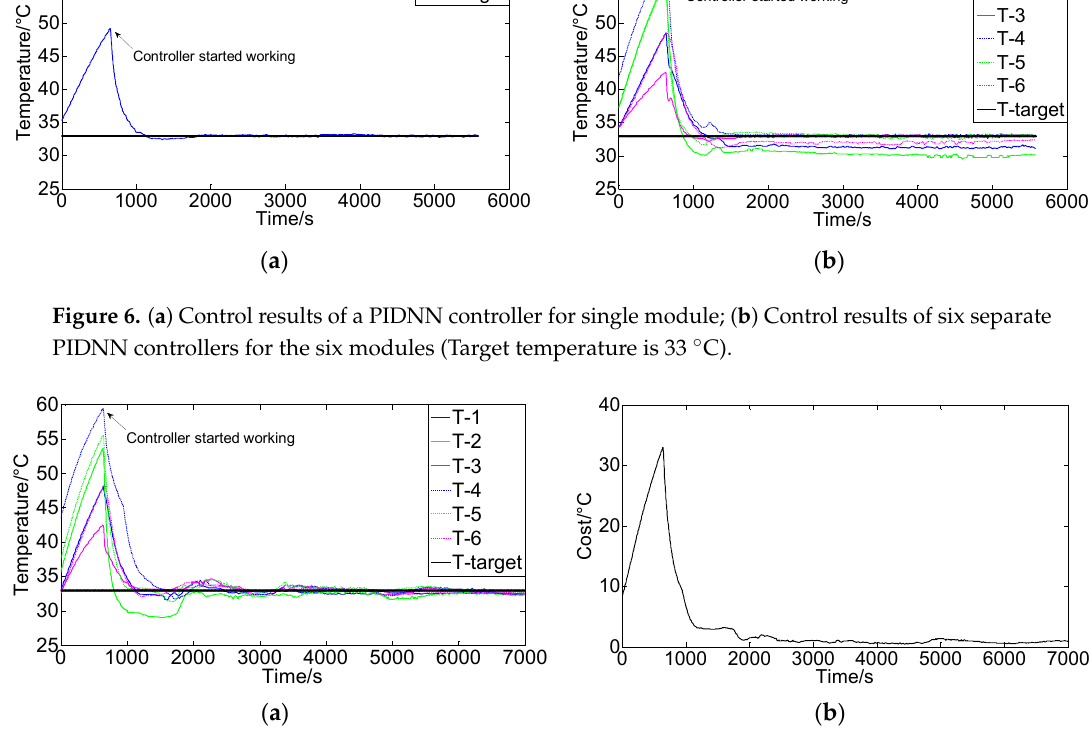
Figure 7. ( a ) Control results of the FCPIDNN controller (Target temperature 33 °C); ( b ) Variation of the square root of the cost function ( (cid:3493) J( n )).